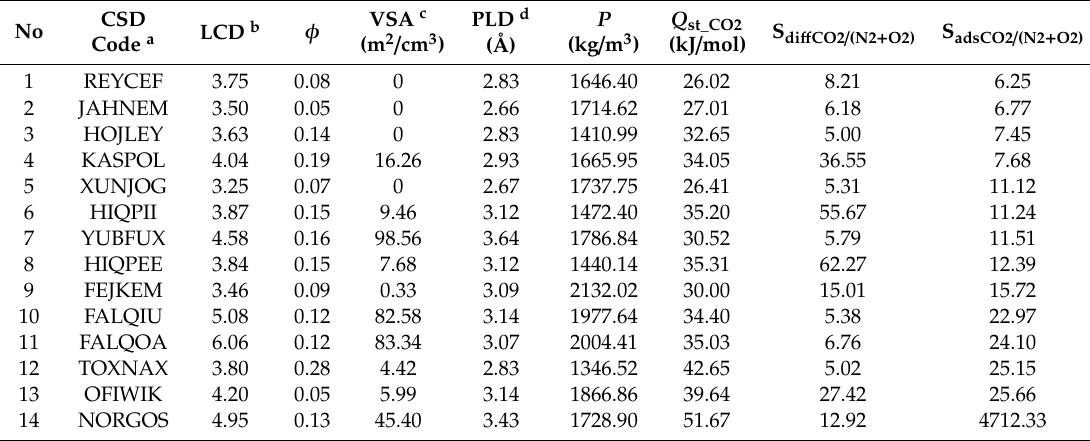
Table 2. Best computation-ready, experimental metal-organic frameworks